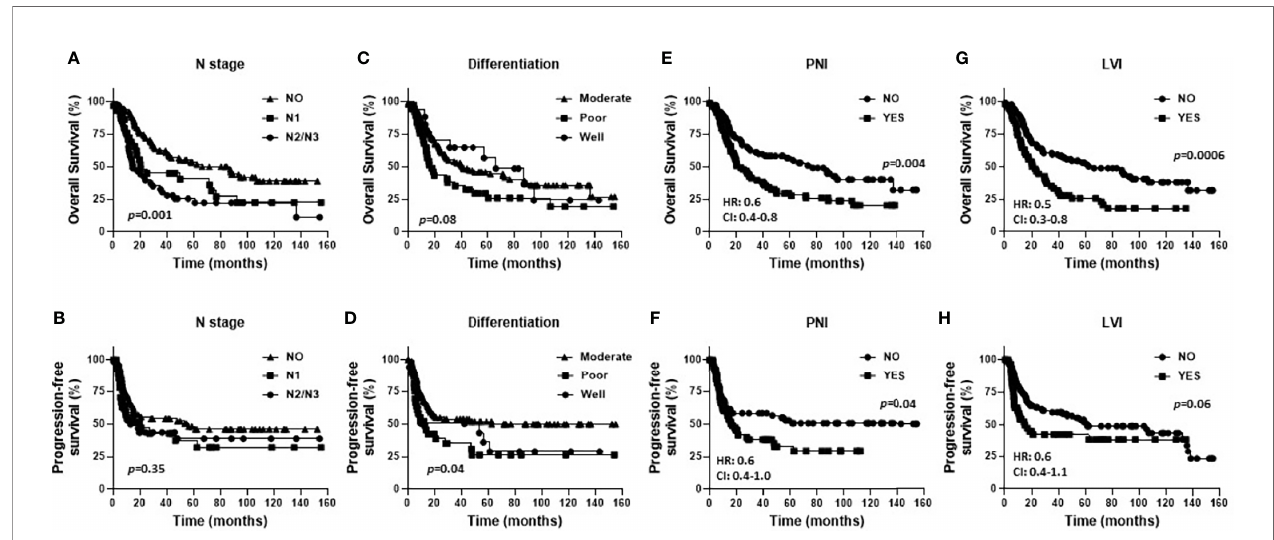
FIGURE 2 | Prognostic impact of pathological factors in OSCCs. Shown are Kaplan-Meier estimates of overall survival (A, C, E, G) and progression free survival (B, D, F, H) of OSCC patients strati fi ed by N stage (A, B) , differentiation (C, D) , presence of perineural invasion (PNI) (E, F) , and presence of lymphovascular invasion (LVI) (G, H) . HR, hazard ratio; CI, 95% con fi dence